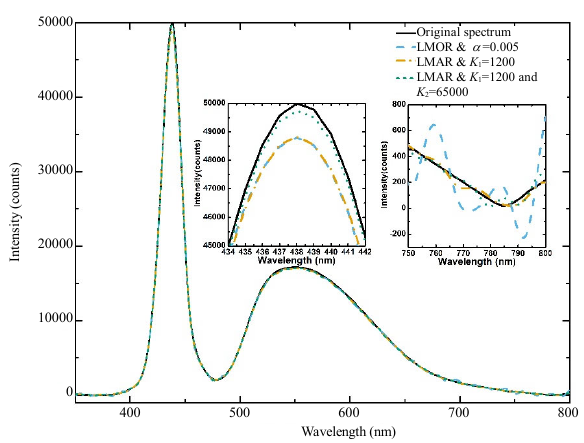
Fig. 7 Original spectrum and corrected spectra of white LED 1#.